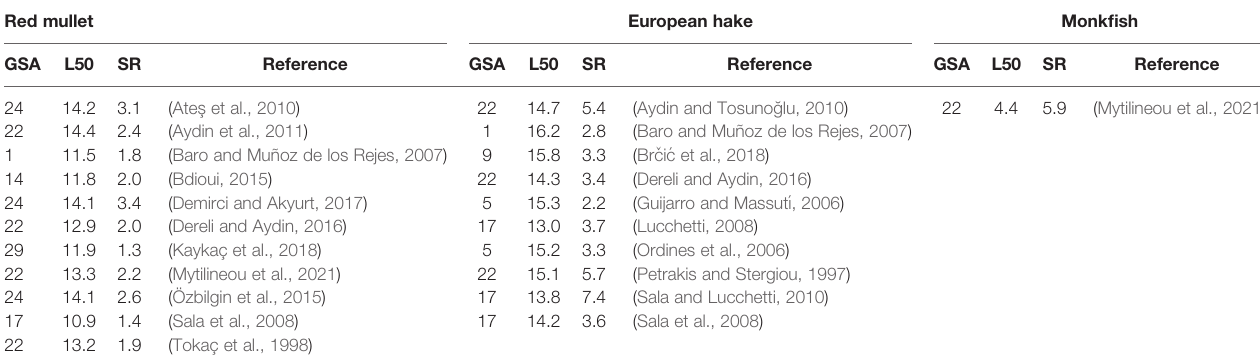
TABLE 7 | Selectivity values (L50 and selection range, SR) obtained for red mullet, European hake and monk fi sh in selectivity experiments carried out in different FAO Geographical Sub-Areas (GSAs) of the Mediterranean with a 40 mm square mesh codend. Red